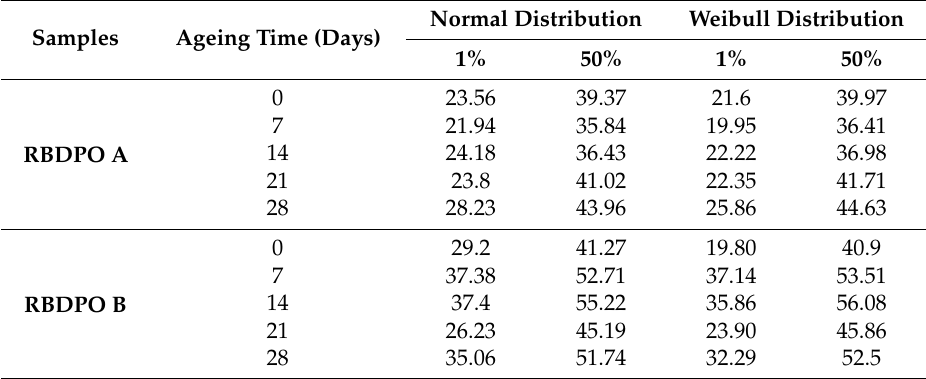
Table 2. Withstand voltage based on normal and Weibull distribution at 1% and 50% probability.